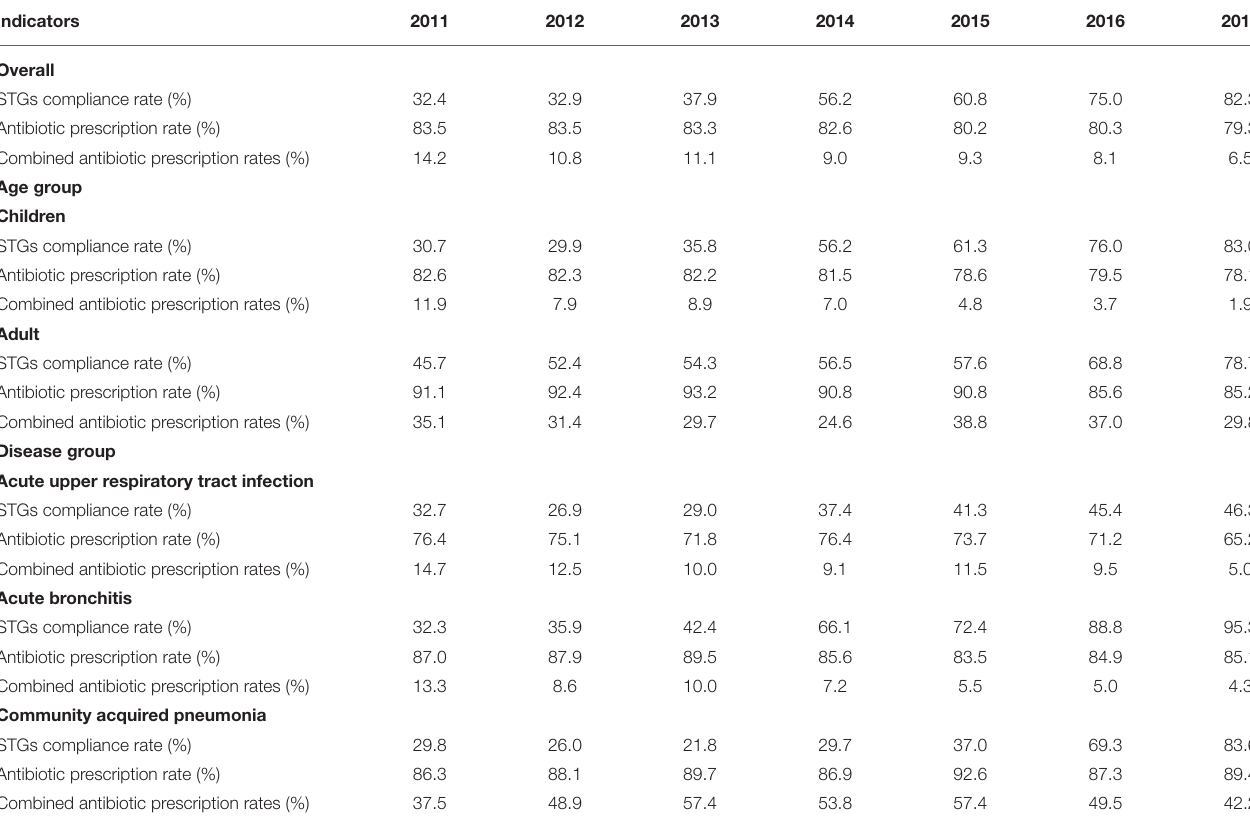
TABLE 2 | Indicators measuring appropriate antibiotic use from 2011 to 2017, by age and disease groups.